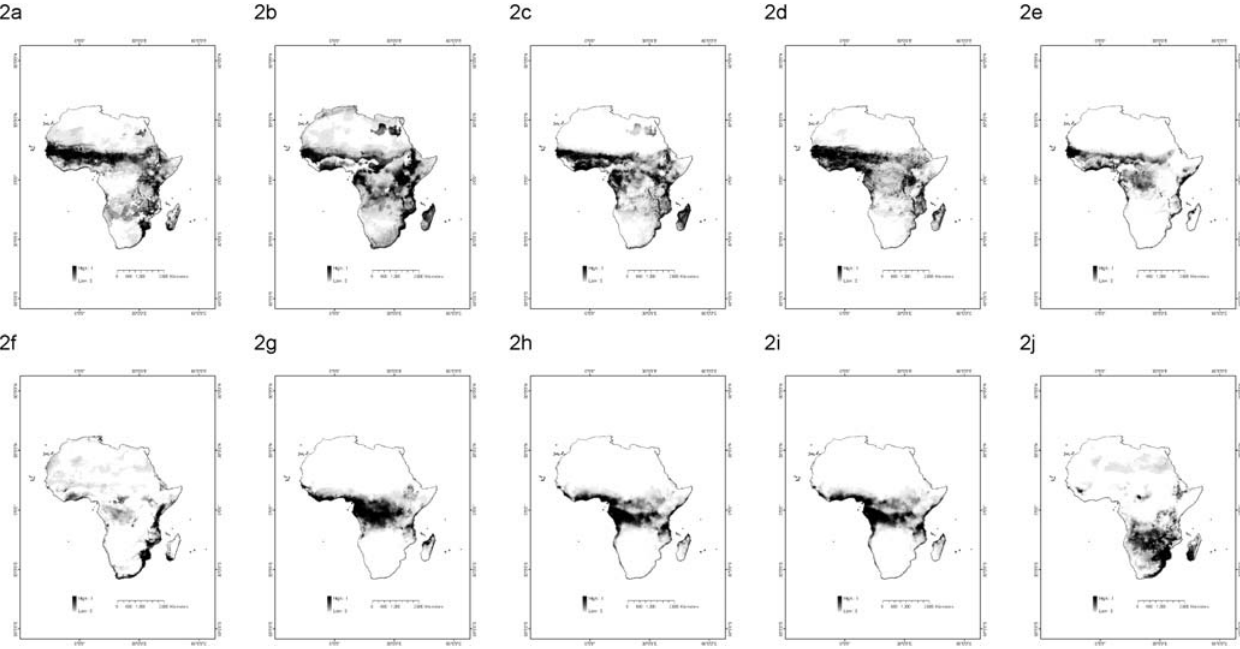
Figure 2. The distributions of 10 malaria vectors in Africa. Distributions are provided for: (a) A . arabiensis ; (b) A . coustani ; (c) A . funestus ; (d) A . gambiae ; (e) A . melas ; (f) A . merus ; (g) A . moucheti ; (h) A . nili ; (i) A . paludis ; (j) A . quadriannulatus .